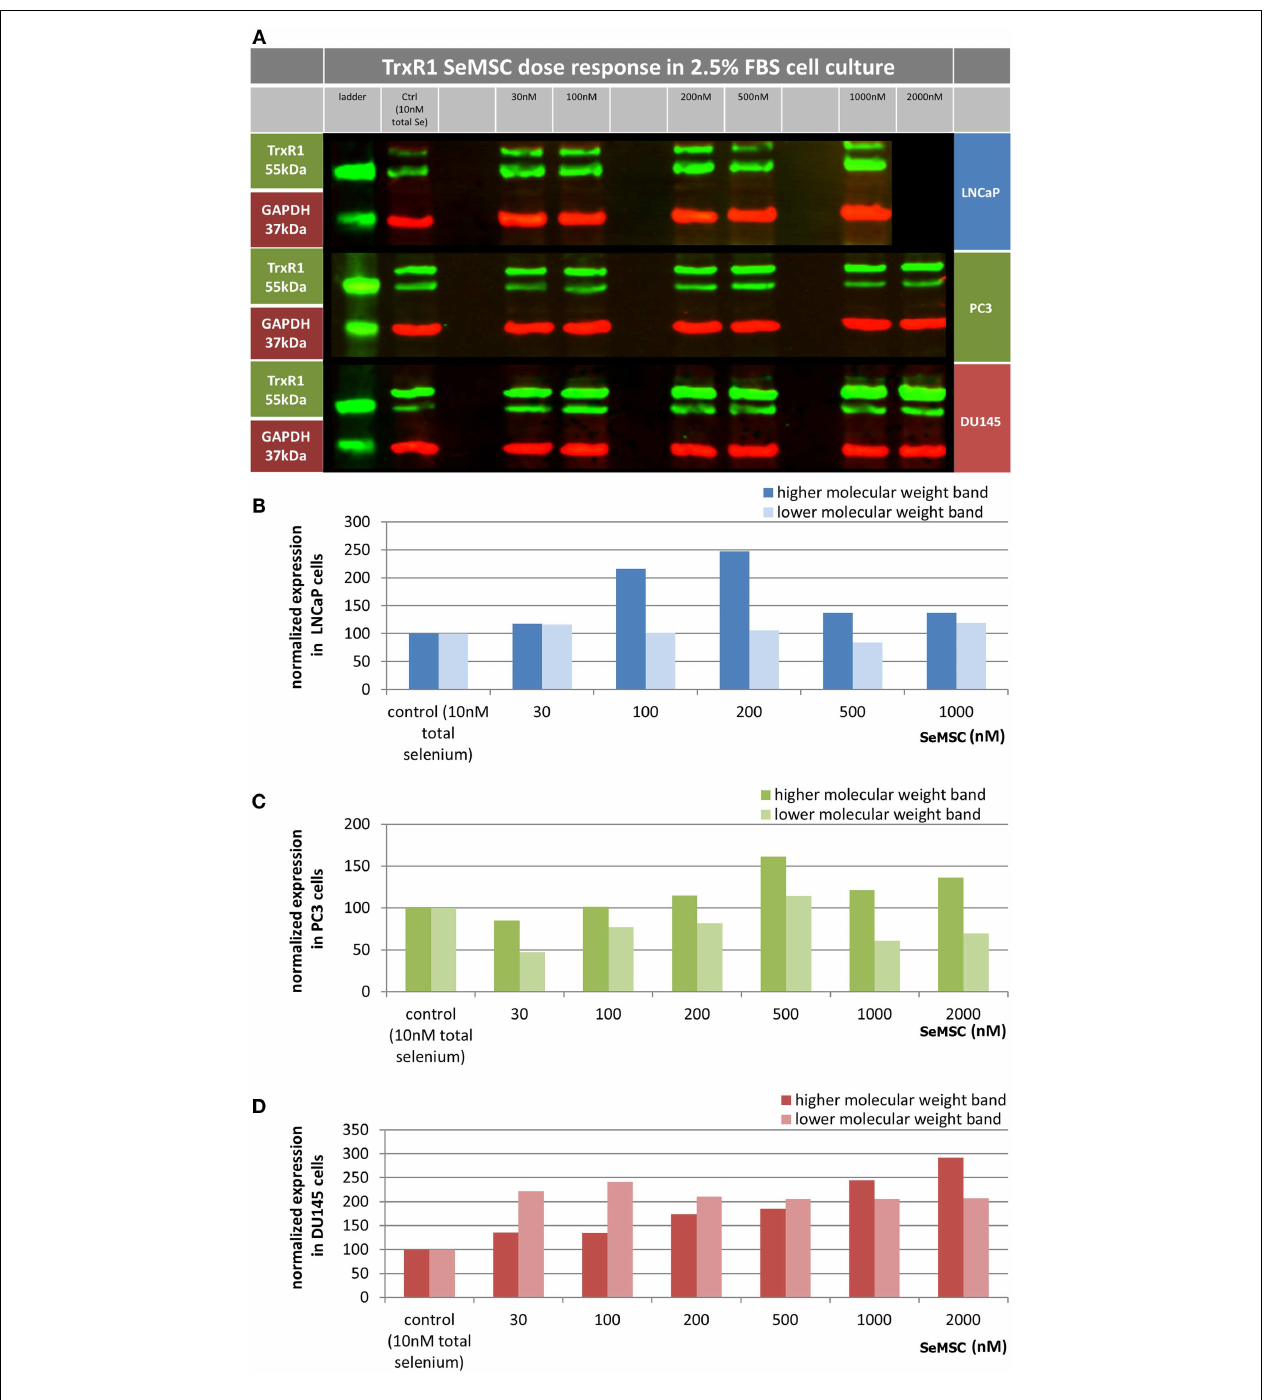
bands in green and loading control GAPDH in red. (B–D) Quantification of TrxR1 expression normalized to GAPDH and expressed as percentage of control with (B) LNCaP, (C) PC3, (D) DU145, no technical or biological